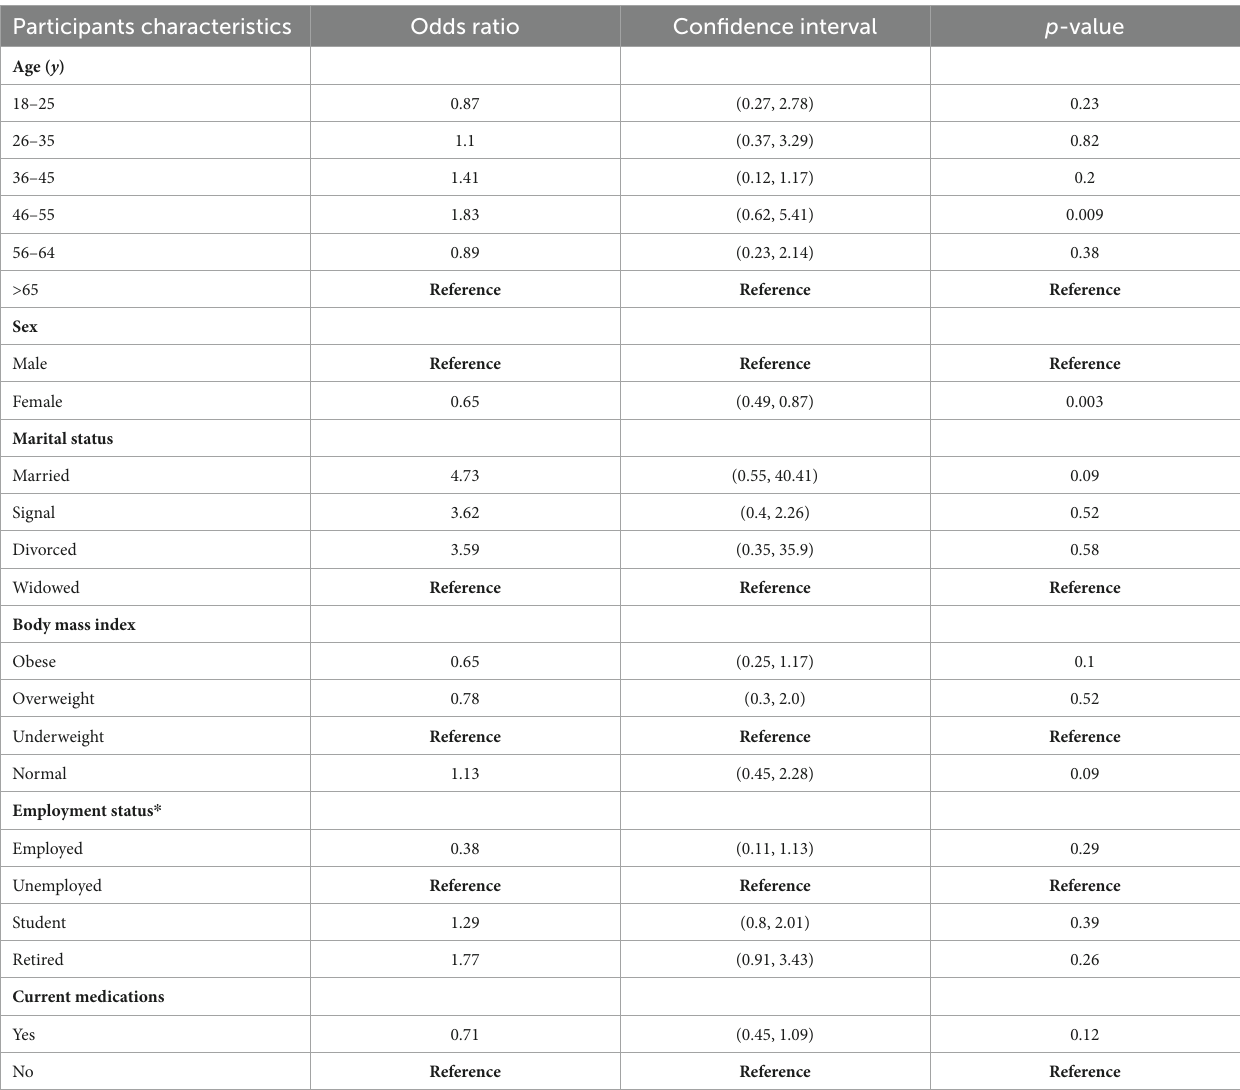
TABLE 3 Predictors of dizziness in the Saudi